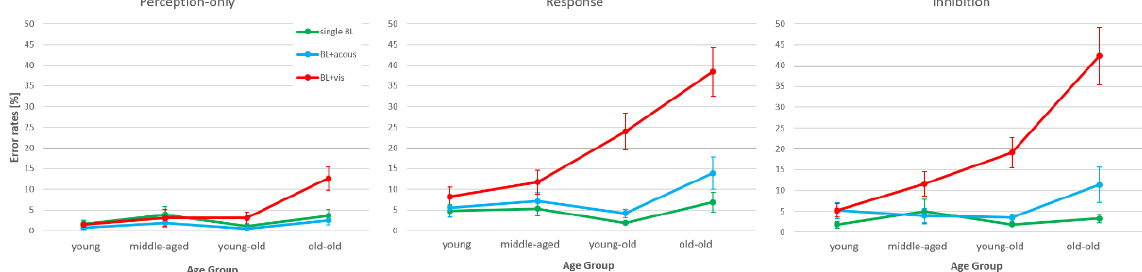
Figure 4. Error rates and standard errors of mean in trials with single brake light (single BL), brake light + acoustic stimulus (BL + acous) and brake light + visual stimulus (BL + vis) of the four age groups, presented separately for perception-only, response and inhibition task.